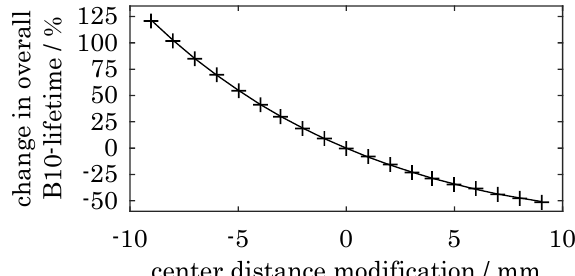
Figure 12: Combined lifetime of group ”gears” for cen- ter distance modifications, Load: 30 / 150 t, Wind speed: Beaufort